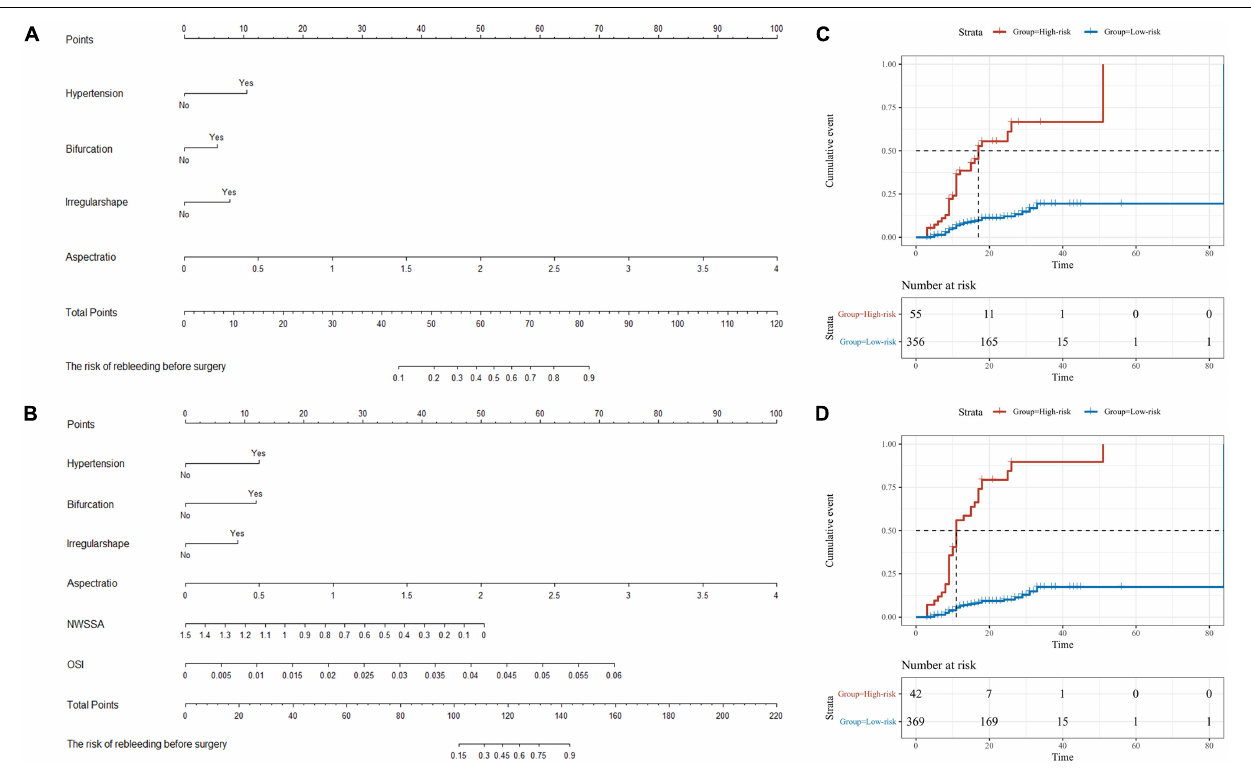
FIGURE 4 | The nomograms for the risk of rebleeding after admission. (A,B) Two nomograms, i.e., clinical + morphological model (CM model) and clinical + morphological + hemodynamic model (CMH model), were presented here. (C,D) With the risk at 50%, all patients were categorized as the high-risk group and the low-risk group. The survival curves showed that the RIAs in the high-risk group might rebleed in a short period after admission. NWSSA, normalized wall shear stress average; OSI, oscillatory shear